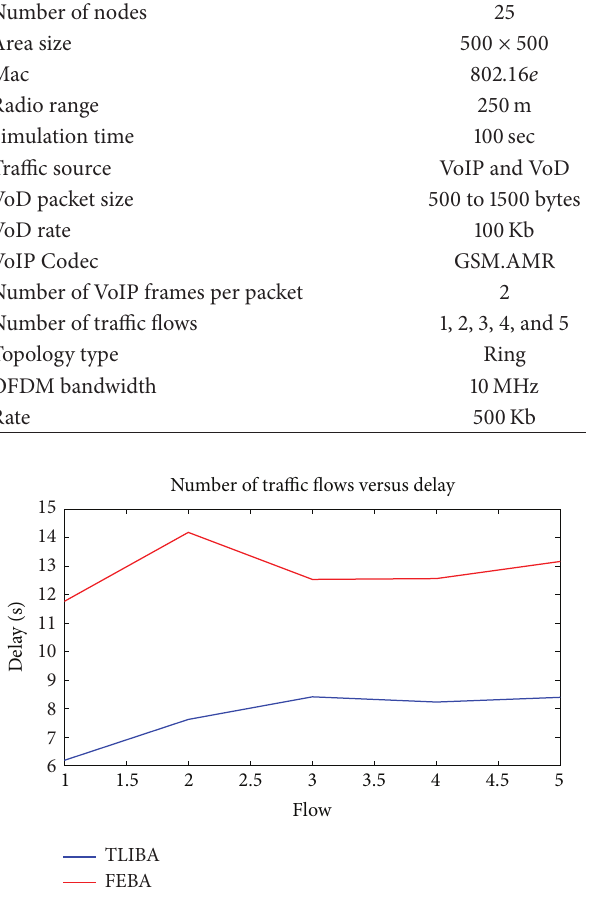
Figure 2: Flow versus delay.